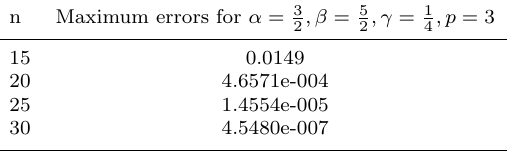
Table 1. Numerical results of maximum errors while n increases.